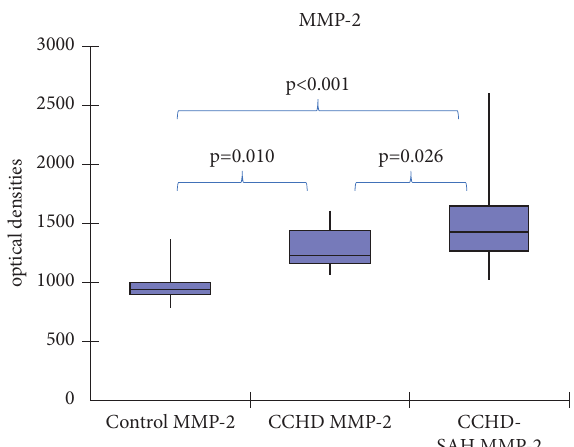
Figure 1: Comparison of MMP-2 plasma levels in controls, in patients with chronic Chagas heart disease (CCHD) alone, and in patients with chronic Chagas heart disease-systemic arterial hypertension